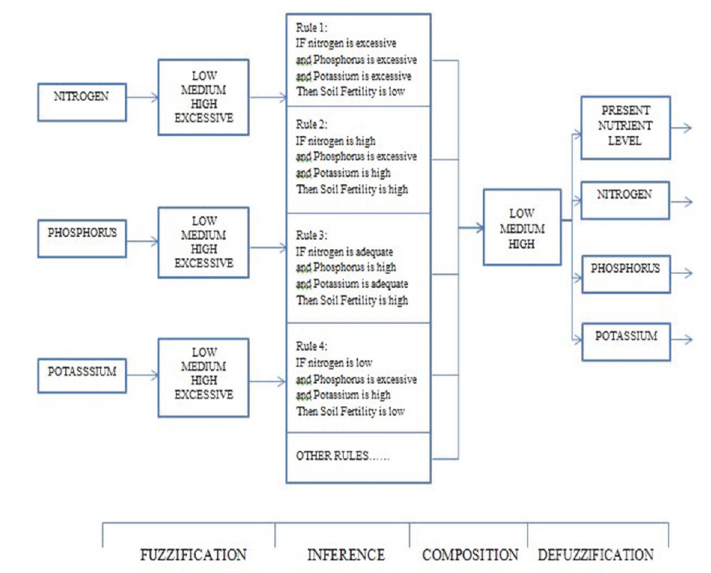
Figure 1: Flowchart of NPK